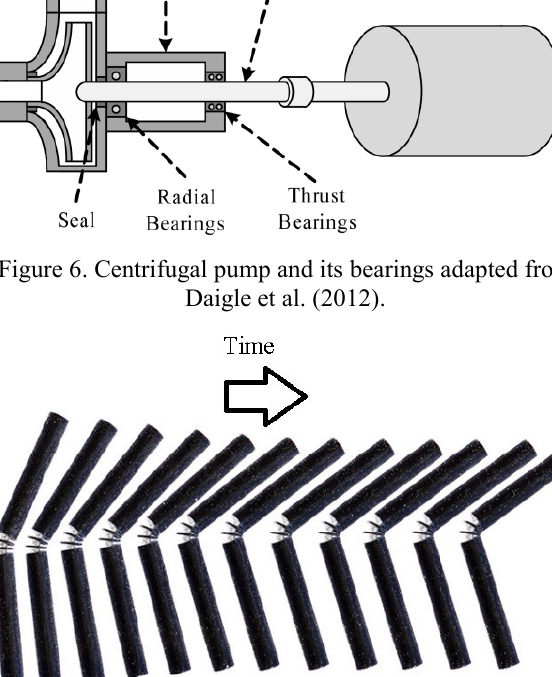
Figure 7. 4D printed structure performing the shape-shifting under water, over time, adapted from Tibbits et al.